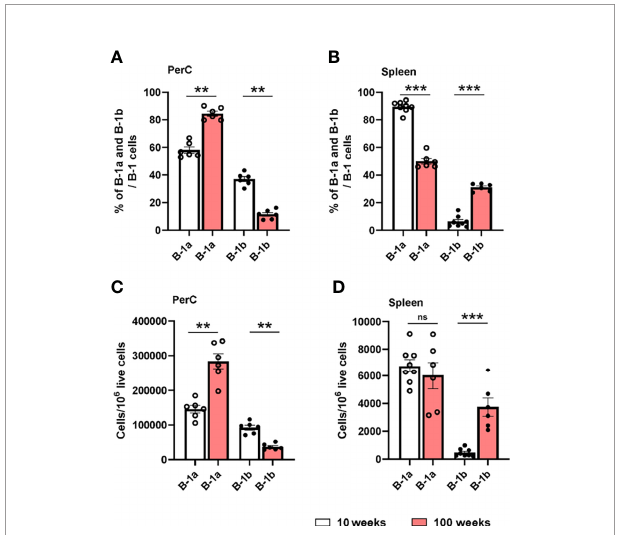
FIGURE 4 | B-1a and B-1b cell distribution in PerC and spleen tissue compartments of both 10- and 100-week-old ApoE -/- mice. B-1a (CD19 hi , B220 low , CD5 + , IgM + ) and B-1b (CD19 hi , B220 low , CD5 - , IgM + ) cell frequencies and numbers were quanti fi ed by using fl owcytometric analysis in PerC (A, C) and spleen (B, D) tissue compartments of both 10-week (n=6-8 mice) and 100-week-old (n=6 mice) ApoE -/- mice. Data from two independent experiments. Results are represented in mean + SEM, unpaired Mann- Whitney test was performed. **p < 0.01, ***p <